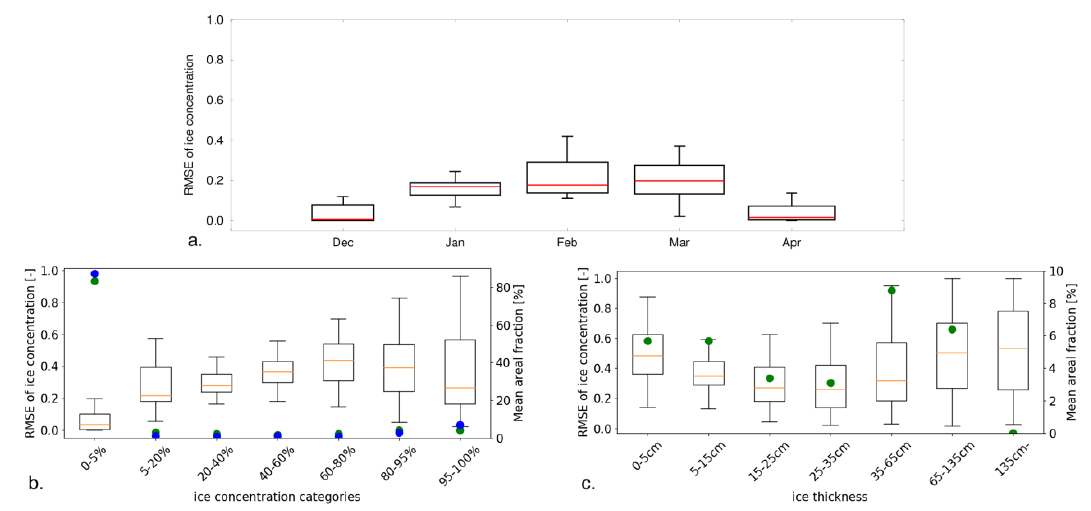
Figure 7. Time series of ice simulation errors between the Lake Michigan-Huron model and the NIC based on the three methods for ( top ) Lake Michigan and ( bottom ) Lake Huron: Pixel-to-pixel RMSE based on ice concentration (cyan), pixel-to-pixel RMSE based on binary ice cover (orange), and lake- wide absolute error (black). Please note that lake-wide absolute error shows only the magnitude of error (i.e., does not show the sign of model bias).